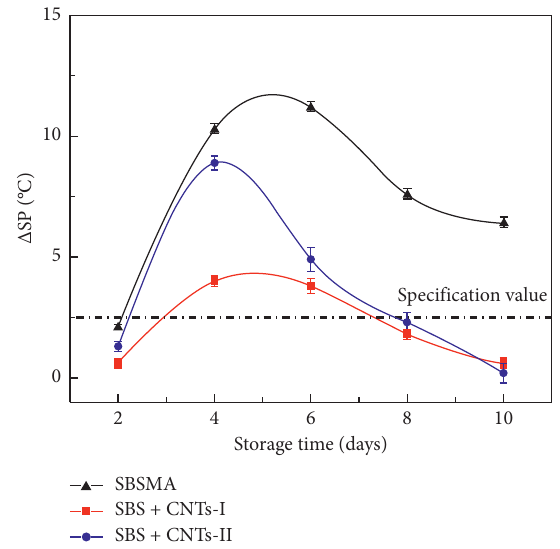
Figure 8: Difference in softening point after separation of three modified